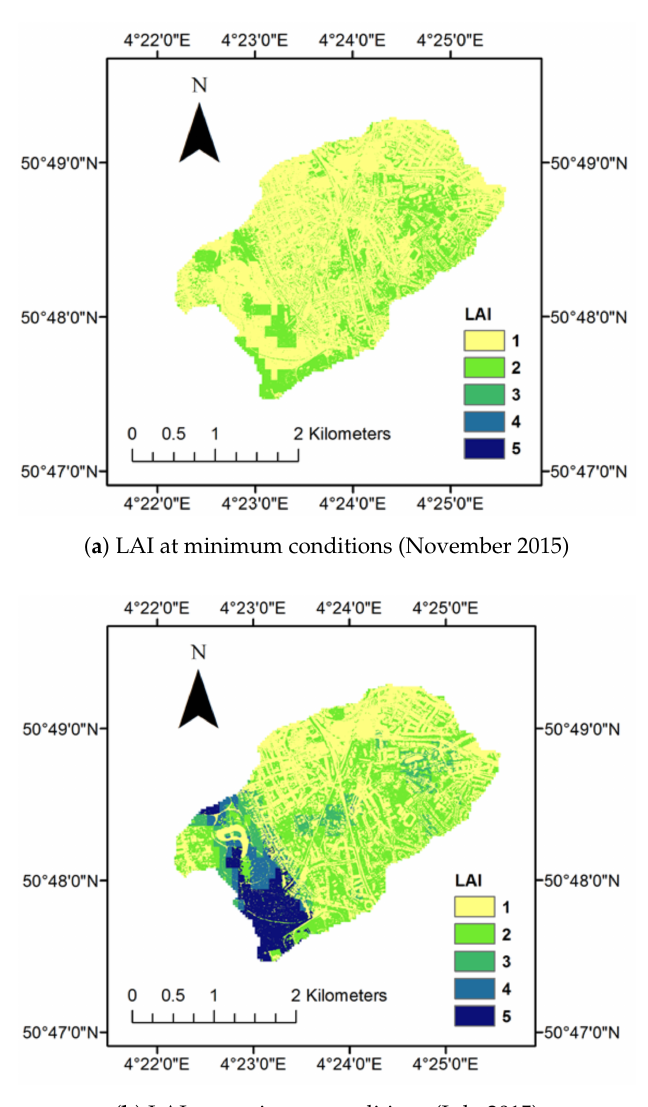
Figure 8. Seasonal LAI maps at ( a ) minimum conditions (November 2015) and ( b ) maximum conditions (July 2015) for the WMB catchment, Brussels,